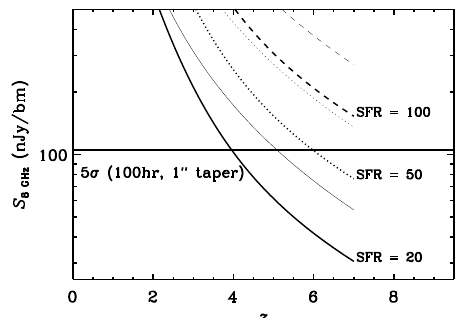
Figure 3. Telescope sensitivity in nJybm − 1 at 8GHz plotted against redshift indicating the expected brightness of a 4kpc disk galaxy forming stars at a rate of 20, 50, and 100 M (cid:12) year − 1 with a magnetic field strength of 35 µ G [61]. The heavy-weighted lines include estimates for synchrotron dimming due to IC scattering of CR electrons/positrons in galaxies due to the increasing CMB energy density with redshift, while the corresponding lighter-weighted lines indicate the expected brightnesses in the absence of any synchrotron dimming due to CMB effects. The horizontal line shows the sensitivity of the ngVLA after a 100h integration and 1 (cid:48)(cid:48) beam taper. The ngVLA will have enough sensitivity to detect galaxies forming stars at a rates down to ∼ 50 M (cid:12) year − 1 into the Epoch of Reionization, while simultaneously resolving the structure of star-forming disks throughout Cosmic Noon